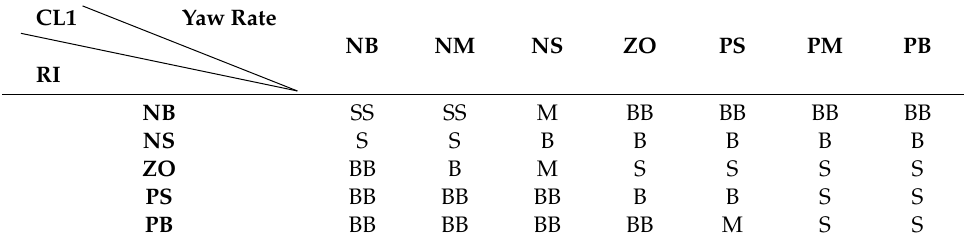
Table 3. Fuzzy rule: RI, yaw angle rate and damping reference coe ffi cient of rear left wheel. RICL2